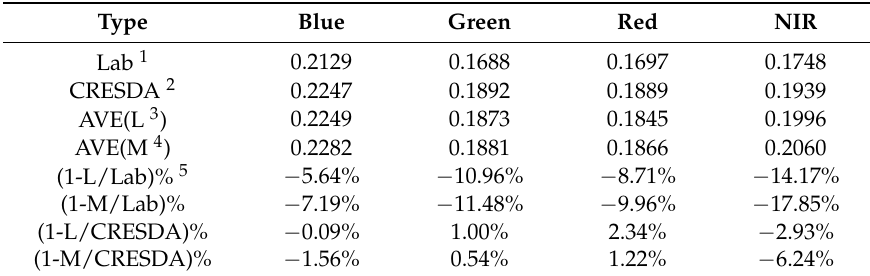
Table 13. Laboratory calibration coefficients, site calibration coefficients and average cross-calibration coefficients and relative error between